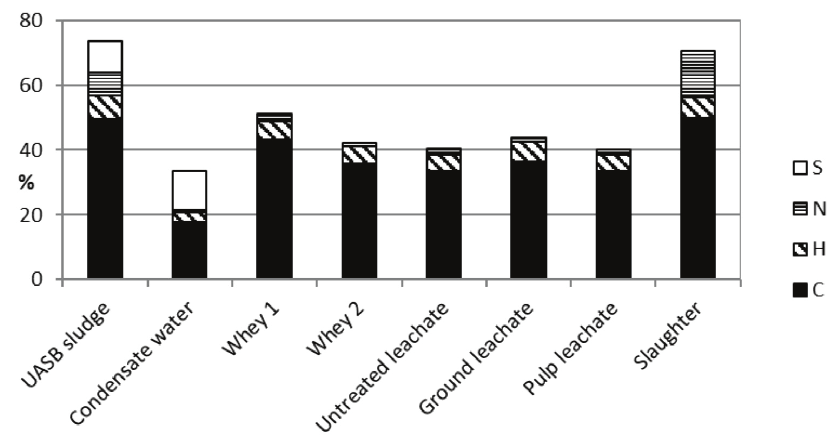
Fig. 2 – Results from elemental analysis of selected substrates, expressed as mean